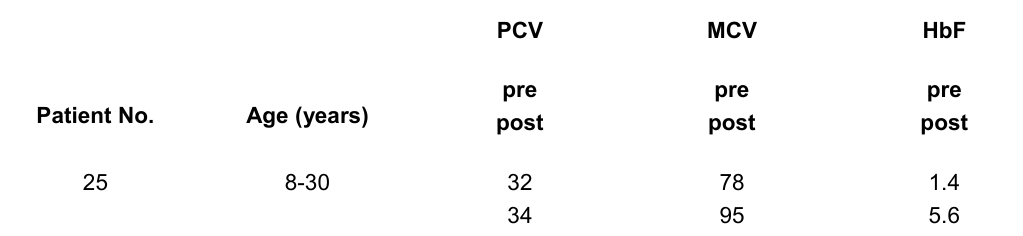
Hematologic Findings in 25 Patients with HbSC Disease Treated with Hydroxyurea Patient No. Age (years)